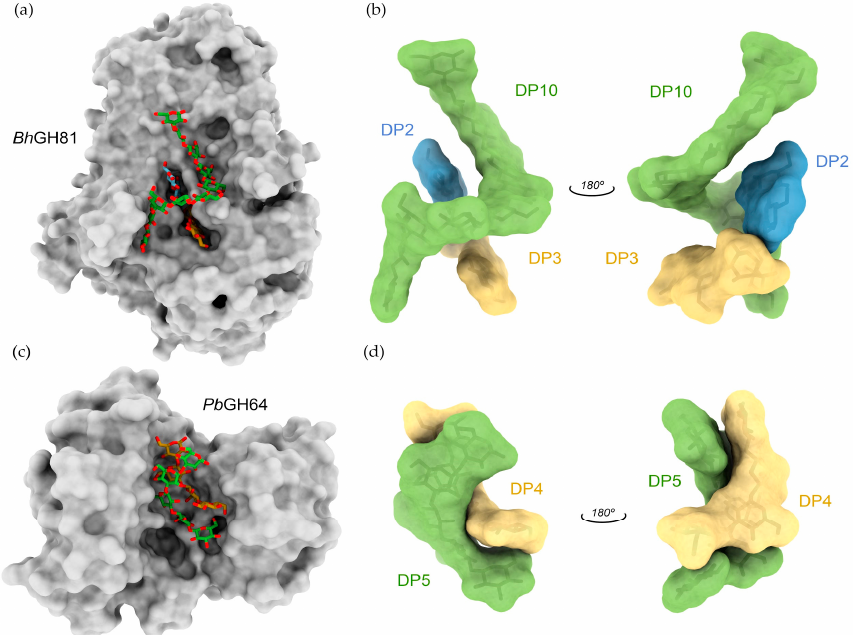
Figure 3. Tridimensional structure of Bh GH81 and Pb GH64 in complex with laminarin oligosaccharides. Gray-colored Van der Waals surface of ( a ) Bh GH81 and ( c ) Pb GH64, with the laminarin oligosaccharides in stick representation bound to the active site, highlighting the β -glucan quaternary structure recognition feature of both enzymes. Panels ( c , d ) show a detailed view of the pseudo-helical structures formed by the bound oligosaccharides. Each oligosaccharide strand is represented in a different color and identified with their degree of polymerization. In ( b ), DP2 and DP3 are likely to be the product of hydrolysis of Bh GH81 on a DP5 laminarin chain, as this is the structure of an active wild-type enzyme. PDB codes: 5t4g ( Bh GH81), 5h9y ( Pb GH64).